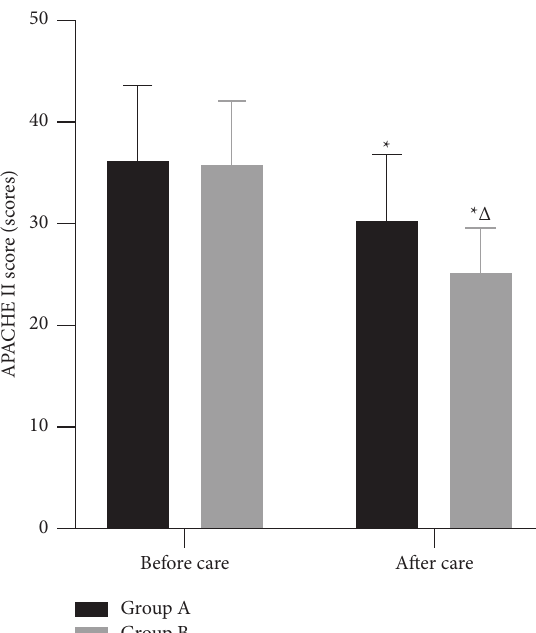
Figure 2: APACHE II score. Note . ∗ and △ represent a comparison with the same group before care and group A after care, respectively, P < 0 .